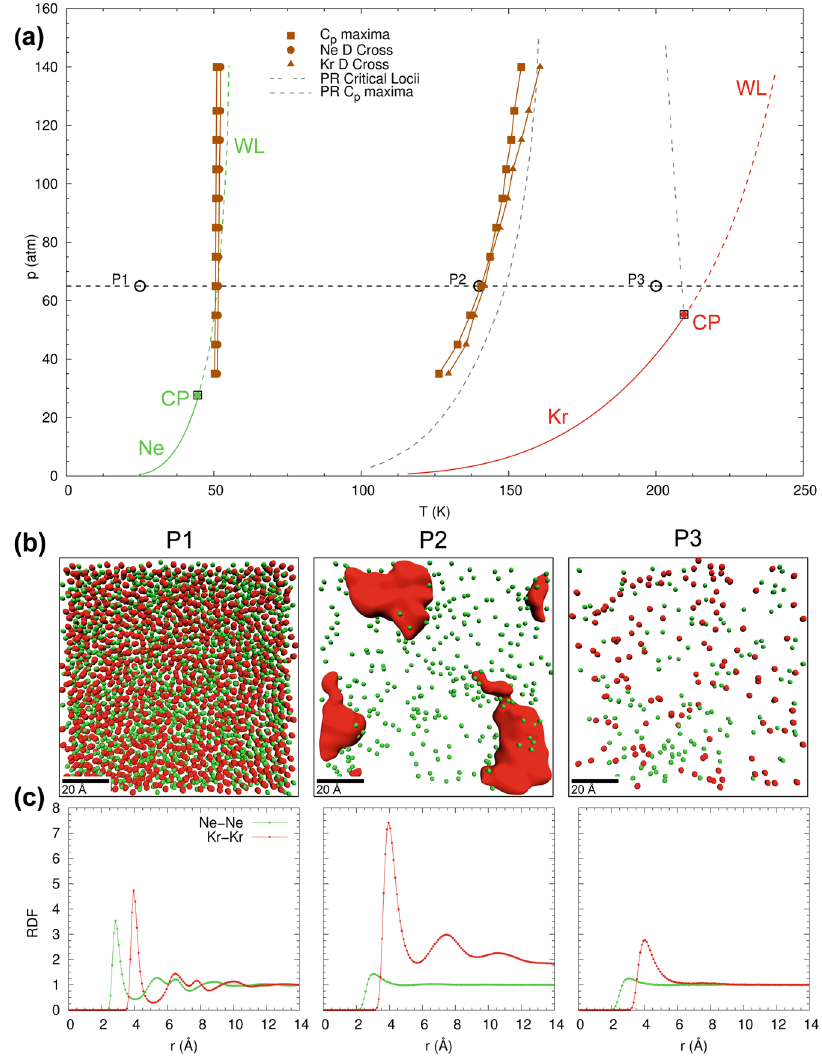
Figure 4. Supercritical state space and molecular structure of equimolar Ne/Kr mixture with type-III phase behavior, showing ( a ) projected p - T state plane with locations of the maxima of C p , α p , κ T and diffusion coefficient crossovers as obtained from isobaric MD-simulations; ( b ) MD-snapshots of molecular structure and ( c ) radial distribution function at a supercritical pressure of 65 atm and three different temperatures (30 K, 140 K, and 200 K; from left to